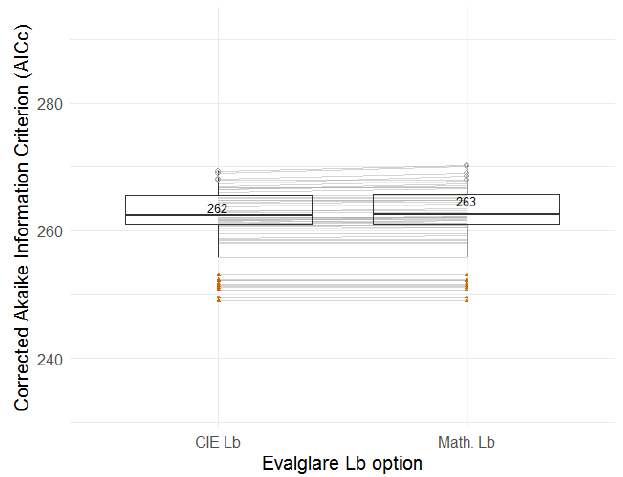
Figure 16. Boxplots of AICc for the two background luminance definitions (field study). Buildings 2018 , 8 , x FOR PEER REVIEW